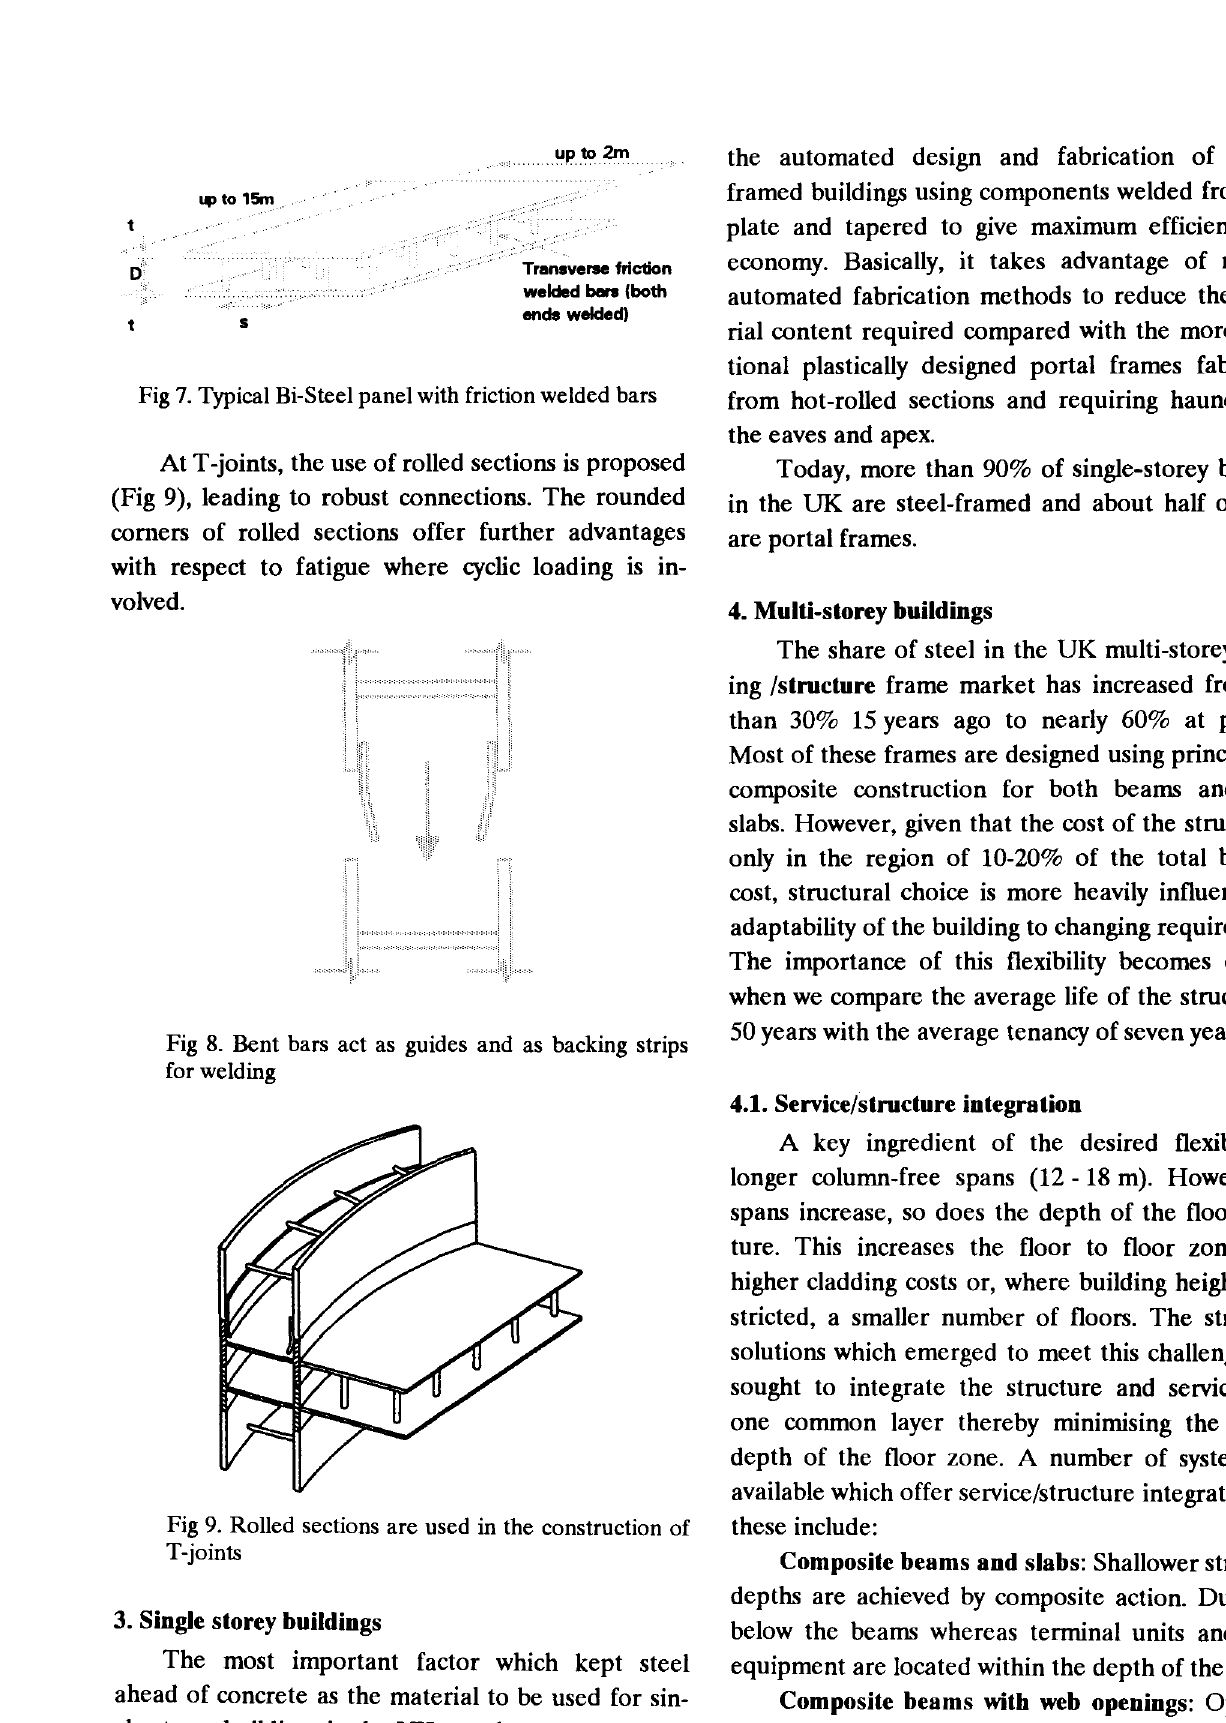
Fig 9. Rolled sections are used in the construction of